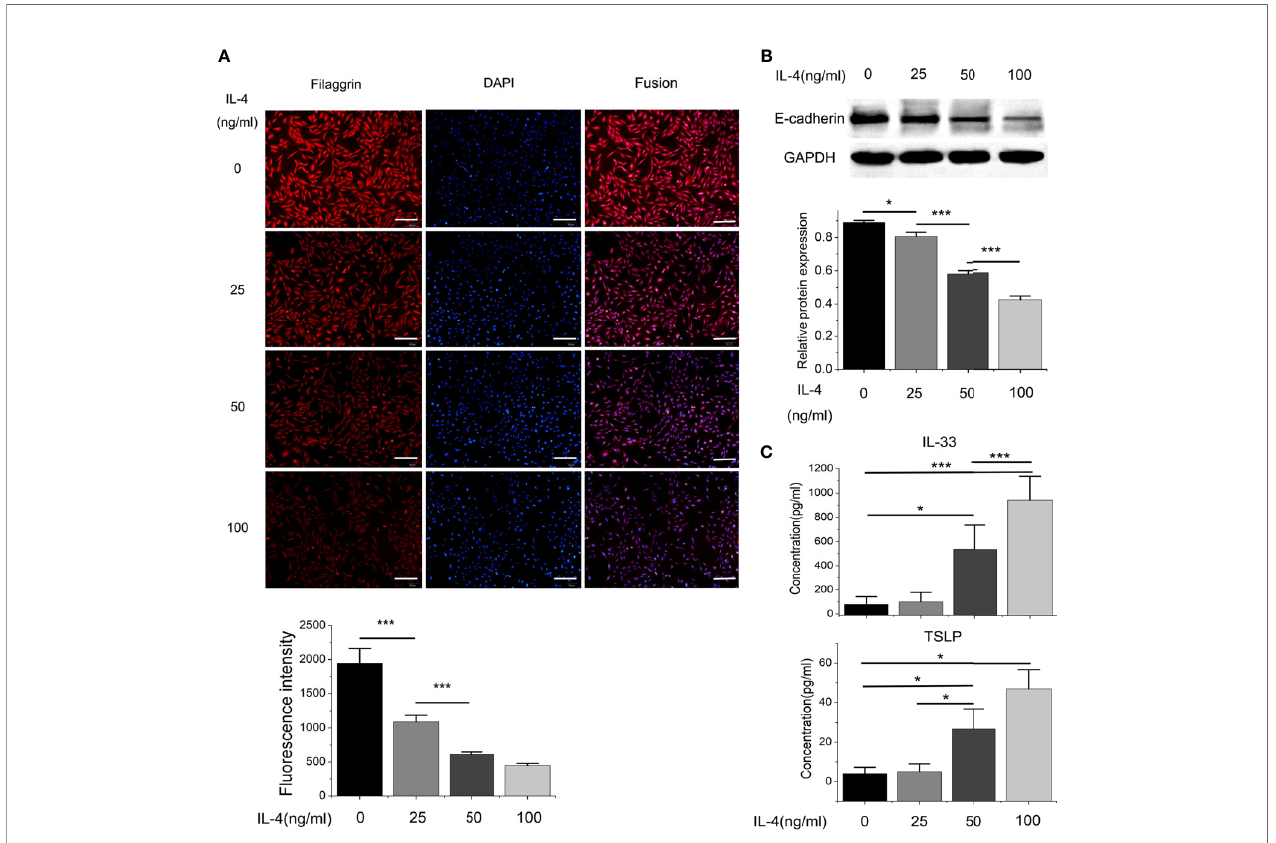
FIGURE 6 | The protein expressions of fi laggrin, E-cadherin, TSLP and IL-33 of BEAS-2B cells with different concentration of IL-4 incubation. (A) The protein expression of fi laggrin in BEAS-2B cells treated with different concentration of IL-4 was detected by Immuno fl uorescence. The photographs were magni fi ed of 200 times and the bars represented 50 m m. (B) The protein expression of E-cadherin BEAS-2B cells treated with different concentration of IL-4 was detected by Western- blot. (C) IL-33 and TSLP in the cell culture supernatants with different concentration of IL-4 treatment were detected by ELISA. Each experiment has been repeated for 3 times and presented as the mean ± SD (n=3). The Student ’ s t-test was used to analyze the difference between groups. *P < 0.05 was considered as statistically signi fi cant. **P < 0.01, ***P <